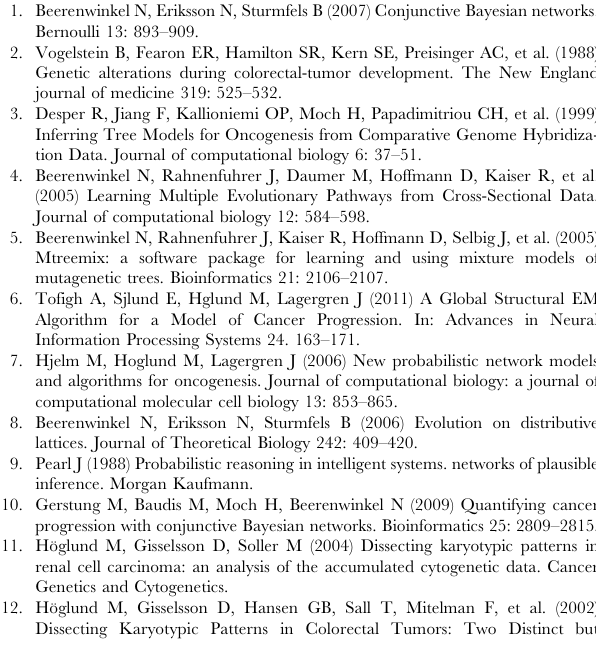
Table S6 Percentage of bad edges and the BIC scores of the SMPNs learned from the BC data in [ 13 ] with DiProg algorithm. (PDF) Table S7 Percentage of bad edges and the BIC scores of the General BNs learned from the BC data in [ 13 ] with DiProg algorithm. (PDF) Table S8 The BIC scores of the MPNs learned from the RCC data in [ 11 ] with DiProg algorithm. As explained in Text S1 of the supplementary material the best value for e that gives the biologically sound PNs is 0.2. For e ~ 0 : 2 the learned MPN with k ~ 3 has the largest BIC score. (PDF) Text S1 Choosing the value of e . (PDF) Text S2 The BIC scores of the MPNs learned from the RCC data in [ 10 ] with DiProg